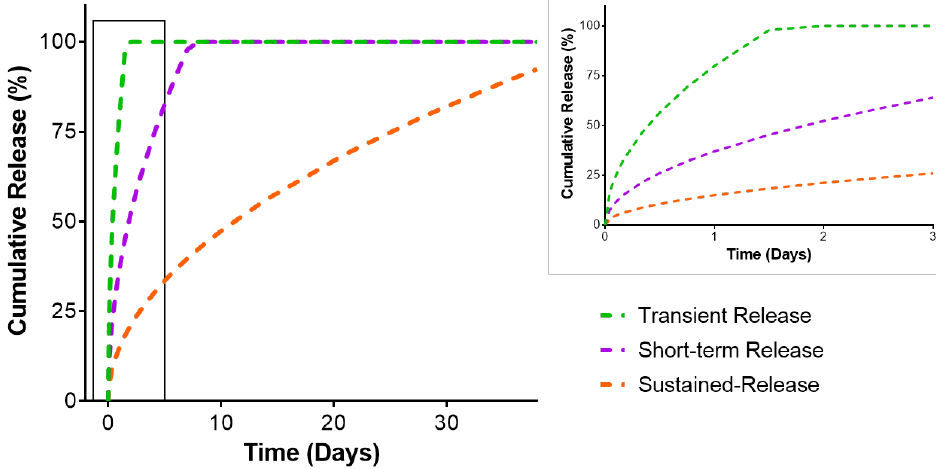
Figure 2. Schematic depicting examples of transient, short-term, and sustained-release profiles.